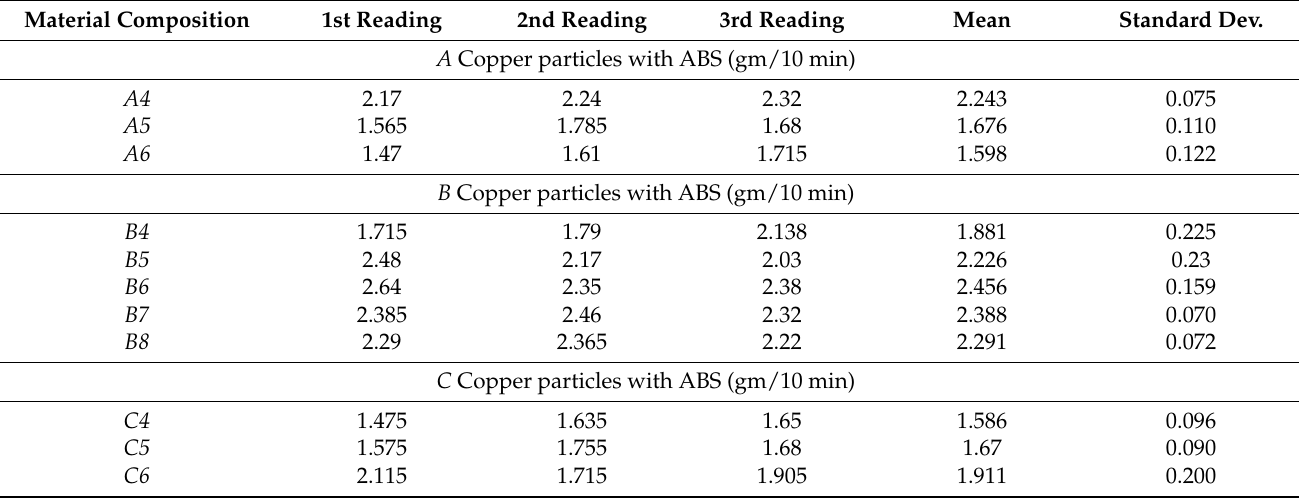
Table 4. MFI of ABS reinforced with single particle size